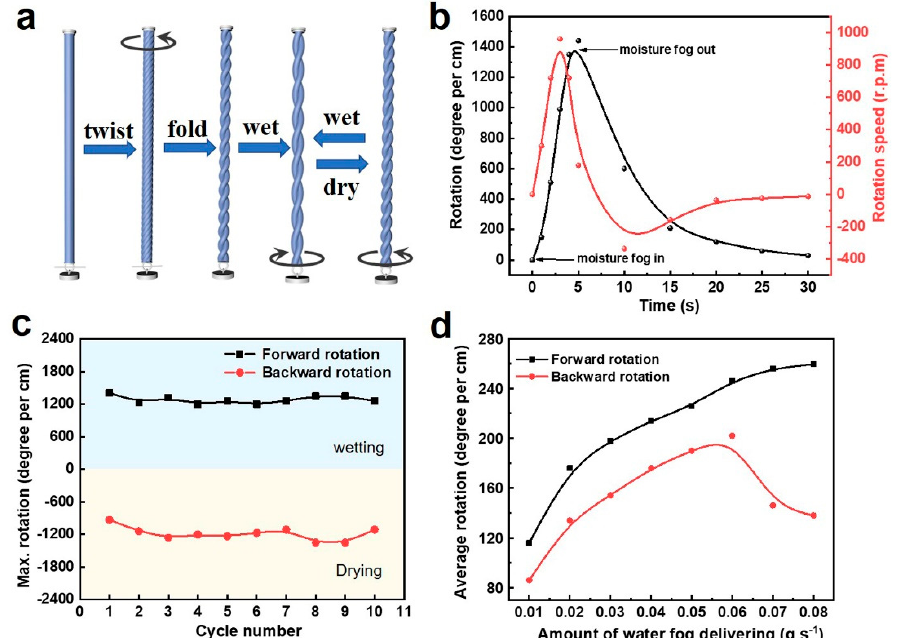
Figure 2. Fabrication and actuation performance of the torsional yarn muscles. ( a ) Illustration of the fabrication of self-balanced torsional yarn muscles. ( b ) Rotation degree (black curve) and rotation speed (red curve) as a function of time upon wetting and drying. ( c ) The durability of the reversible torsion when alternatively exposed to wet and dry over 10 cycles. ( d ) The evolution of average rotation and reverse degree with different amount of water fog delivering.